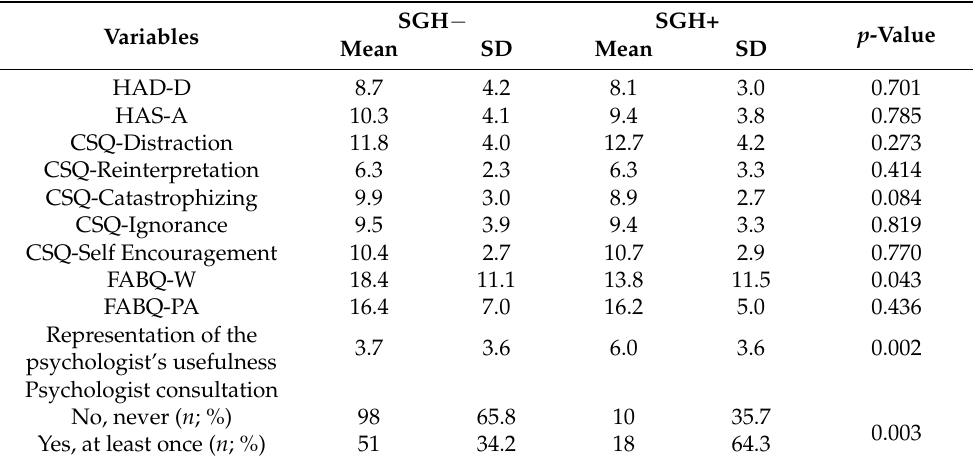
Table 4. Comparison of patients’ psychological characteristics according to the Social Gradient of Health (SGH).